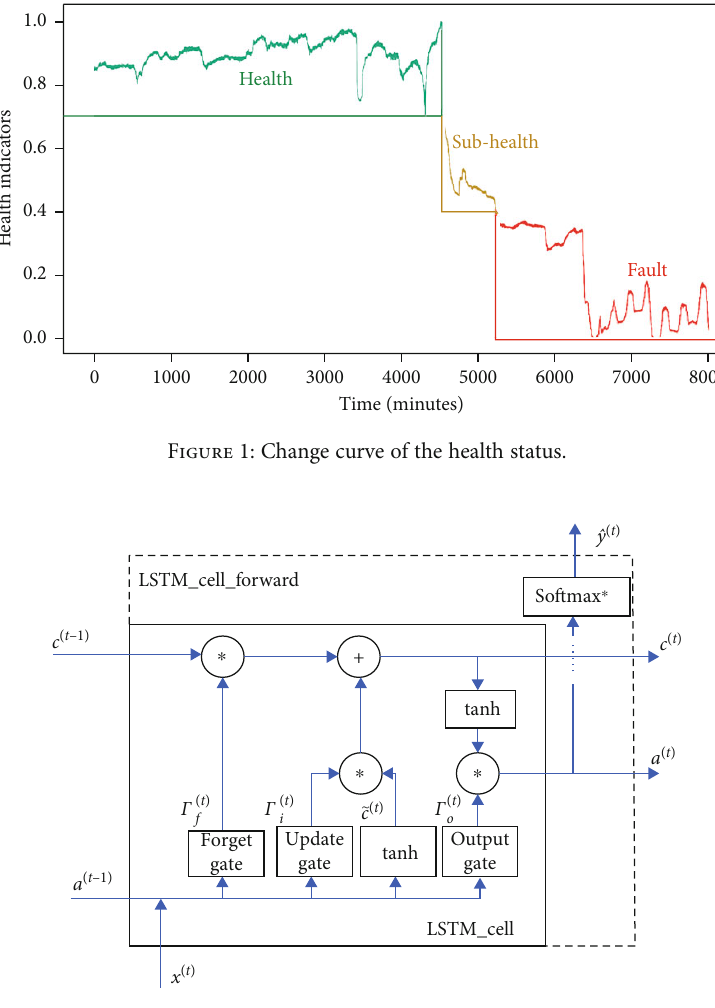
Figure 2: Cell structure of